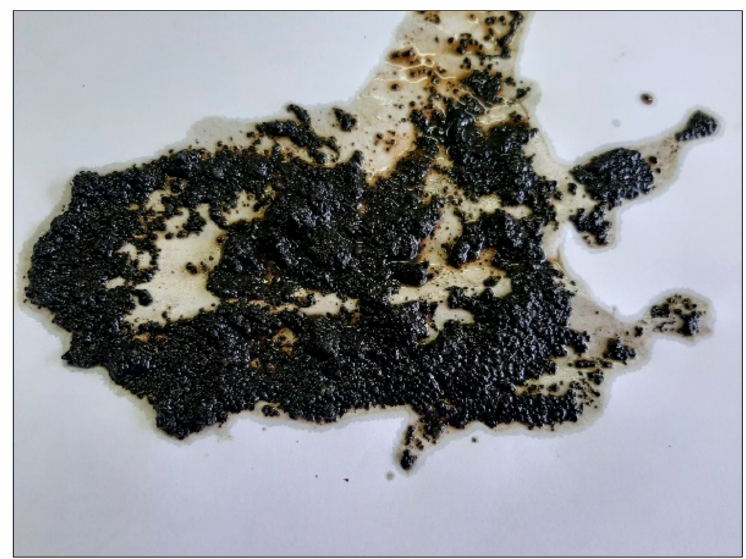
Figure 3. Granular seed sludge.